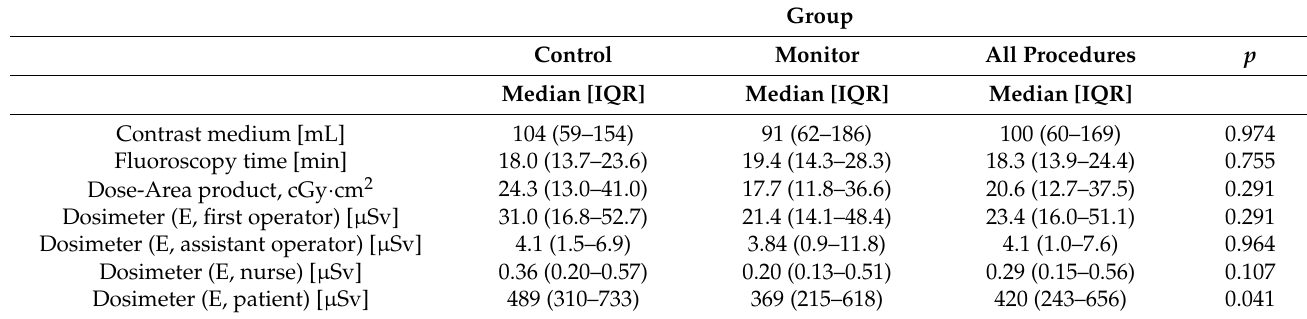
Table 3. Exposure in procedures lasting >60 min.